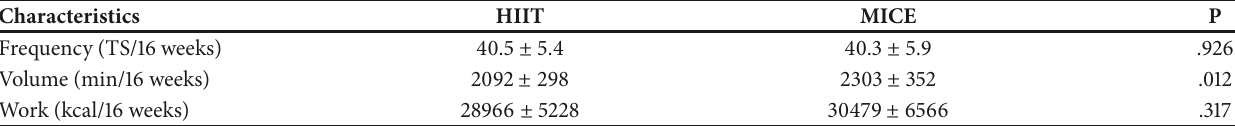
Table 2: Training characteristics HIIT versus MICE.